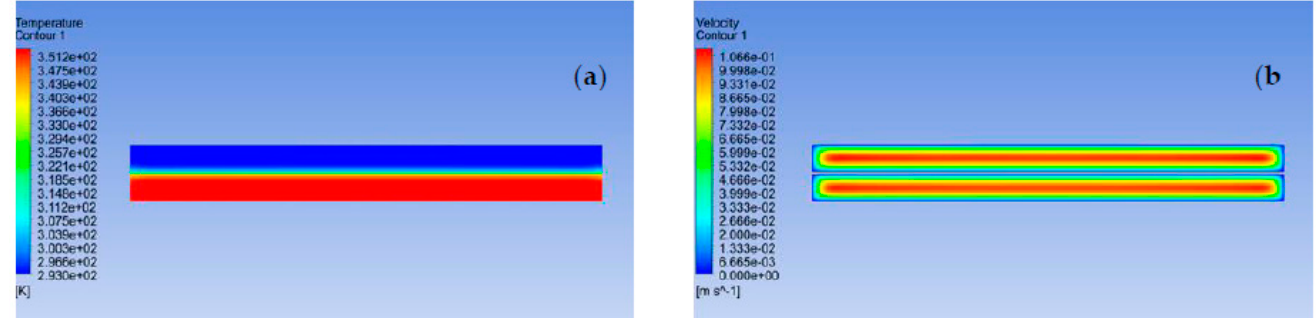
Figure 5. ( a ) Temperature and ( b ) velocity contours of DCMD numerical model of the PS/MWCNTs composite membrane running at 20 and 80 °C inlet temperatures of permeate and feed channels, respectively, and porosity of 0.72.